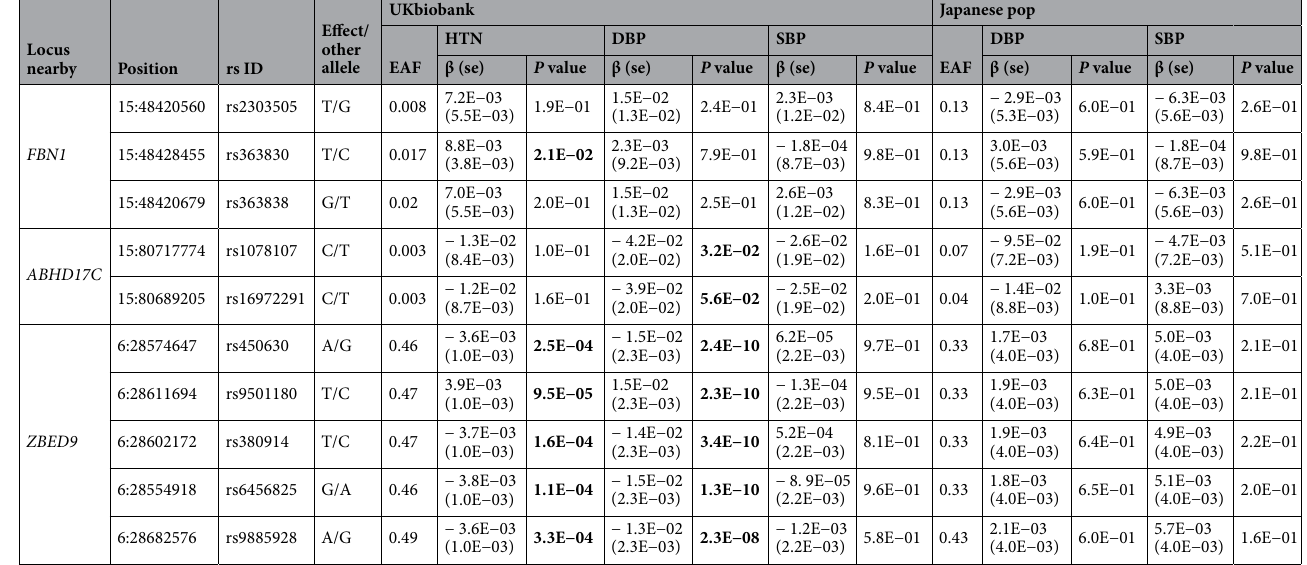
Table 3. Association of GWA findings on BP traits in UKbiobank and Japanese population. EAF effect allele frequency, β effect estimate, se standard